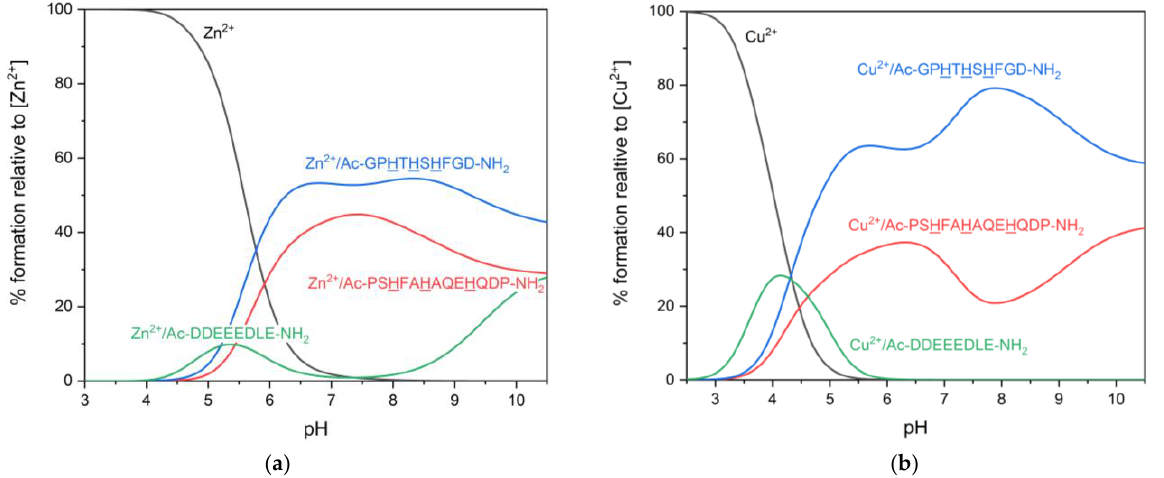
Figure 5. Competition plots for a solution containing equimolar concentrations (1 × ∙10 − 3 M) of L1, L2, L3 and ( a ) Zn 2+ ; ( b ) Cu 2+ .